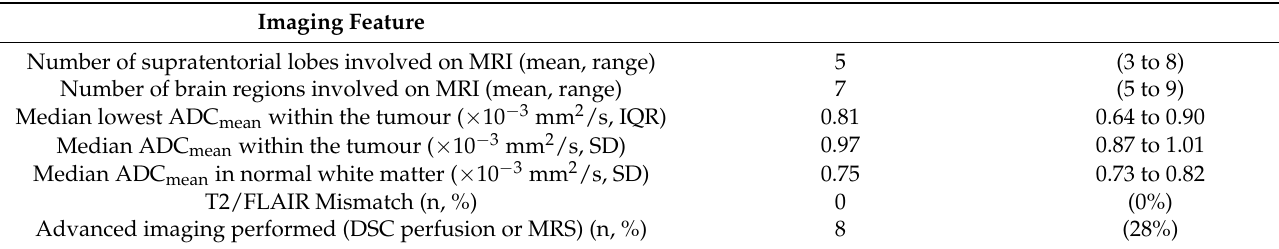
Table 2. Imaging features on the first available MRI examination. Imaging Feature